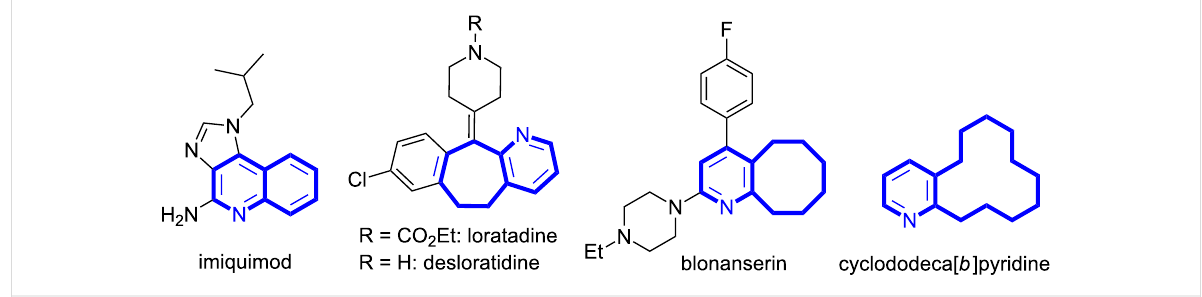
Figure 1: Examples of biologically important cycloalkyl-fused pyridines.